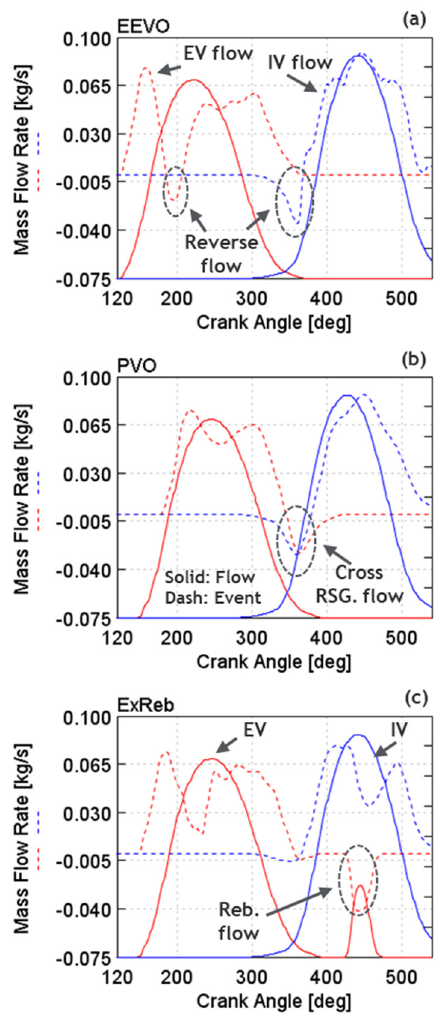
Figure 10. EV and IV flow trends for the ( a ) EEVO, ( b ) PVO, and ( c ) ExReb strategies for Tivc of 404 K at B10.